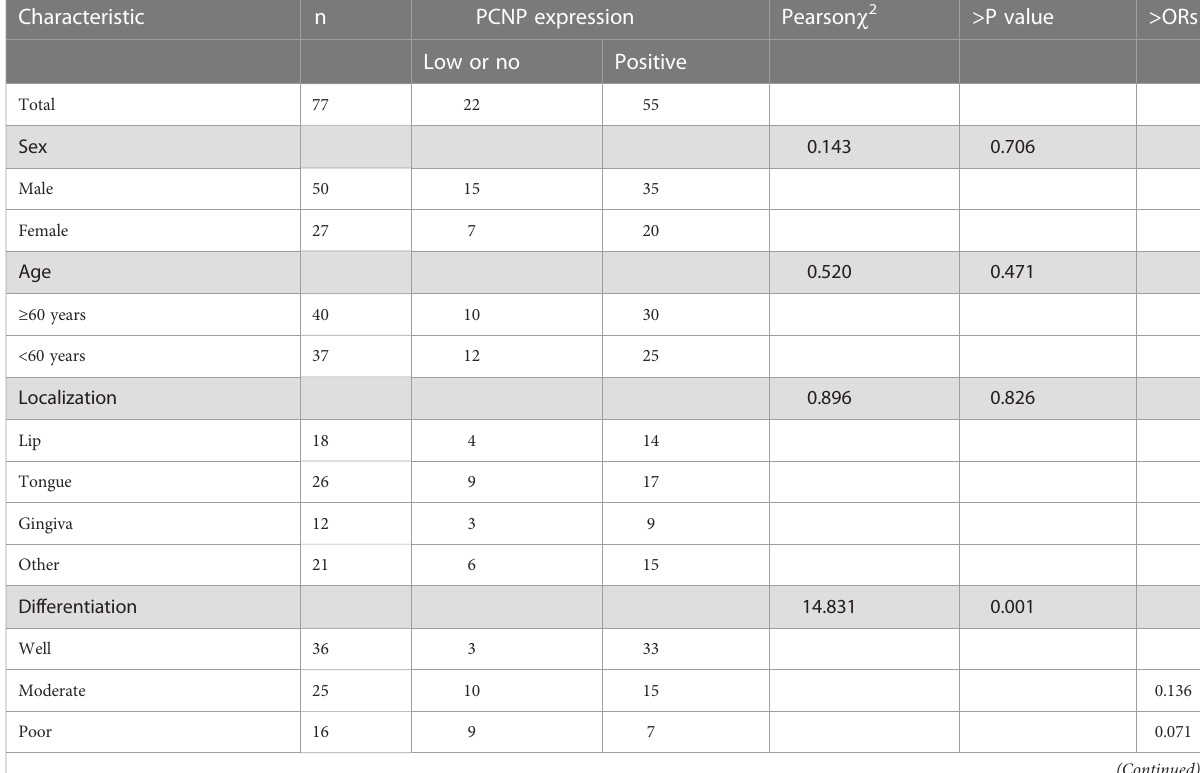
TABLE 1 Relationship between PCNP expression and clinical features of